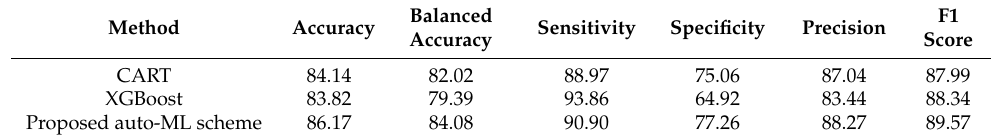
Table 2. Performance comparison of three methods in the experiment (in percentage).